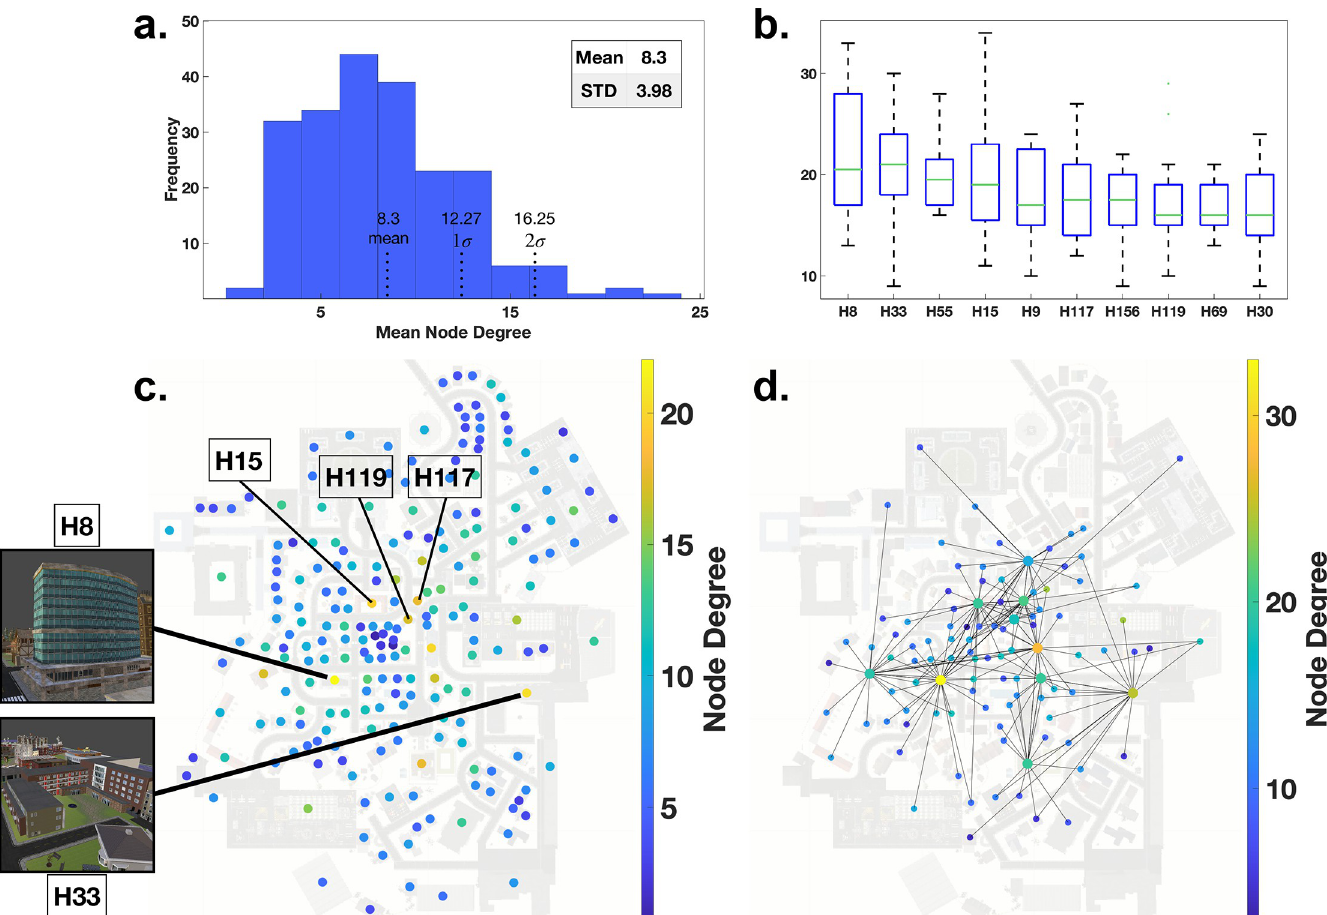
Fig 7. The high node degree centrality houses. (a) The mean node degree distribution across all participants with mean, 1 σ - and 2 σ -thresholds. (b) A box plot of the 10 houses with at least 2 σ -distance to the mean node degree. (c) A map plot with all nodes color coded with their respective average node degree across all participants. (d) The 10 houses, which exceeded the 2 σ -distance to the mean displayed on the map for our example participant with all their connections and color coded with their respective node